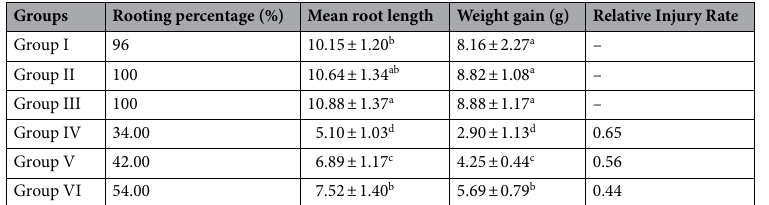
Table 2. Effects of penoxsulam and BBE on morphological parameters. Group I: tap water (control), Group II: 25 mg/L BBE, Group III: 50 mg/L BBE, Group IV: 20 μg/L penoxsulam, Group V: 20 μg/L